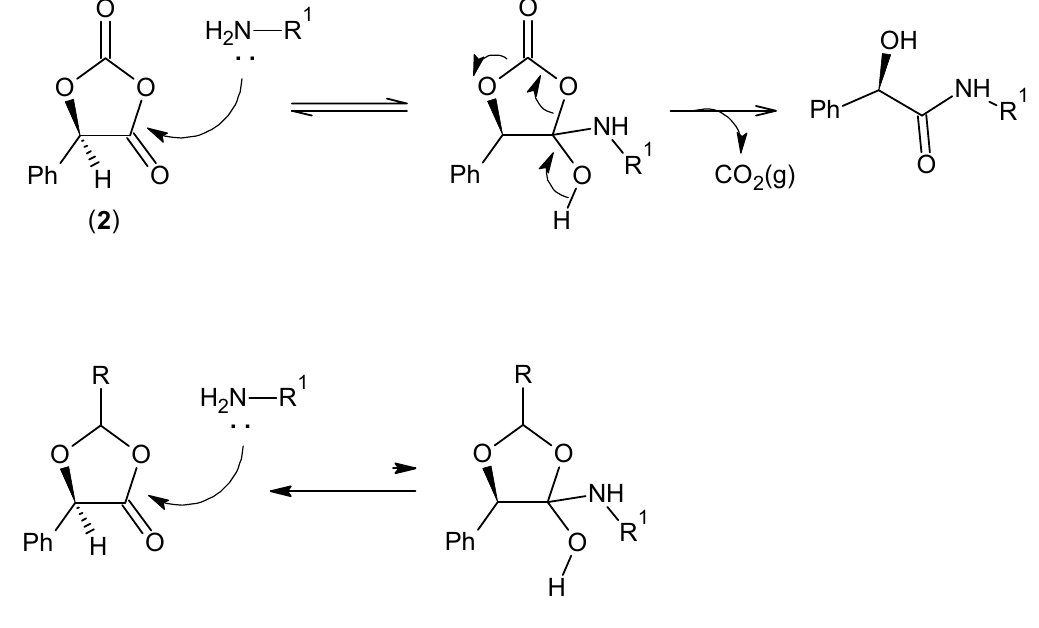
Figure 4. OCA decarboxylation.